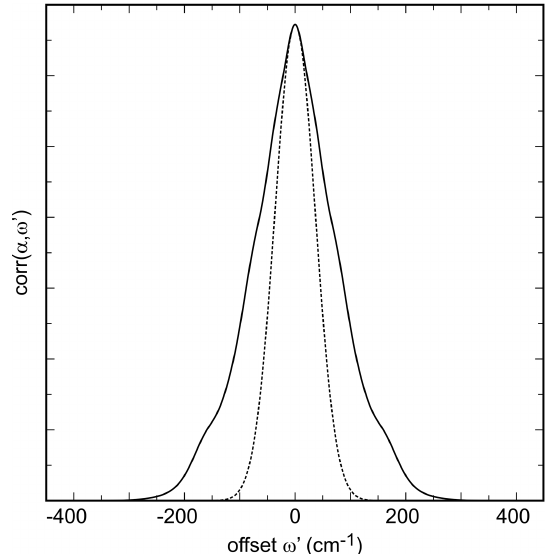
Figure 3. Autocorrelation spectrum of the synthetic olivenite from this work from the spectral range of 660 to 1250cm − 1 . The dotted curve is a Gaussian fit to the central portion of the autocorrelation